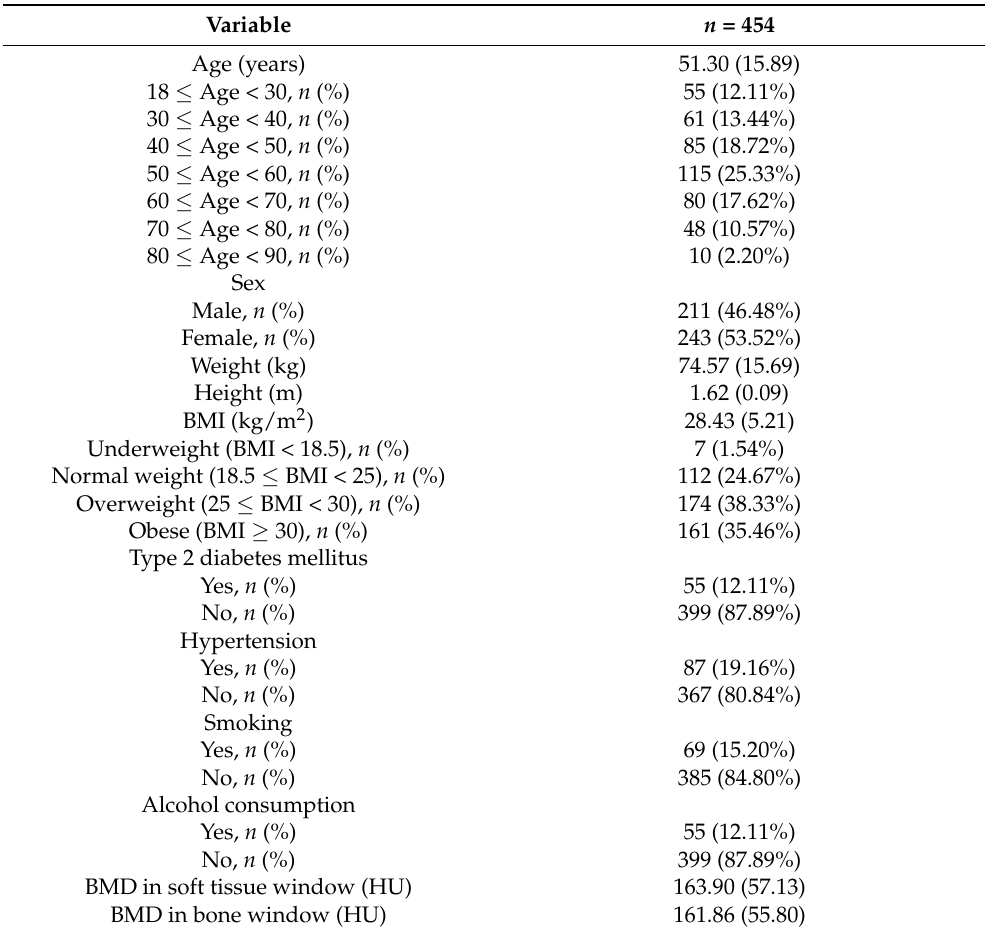
Table 1. Characteristics of the study